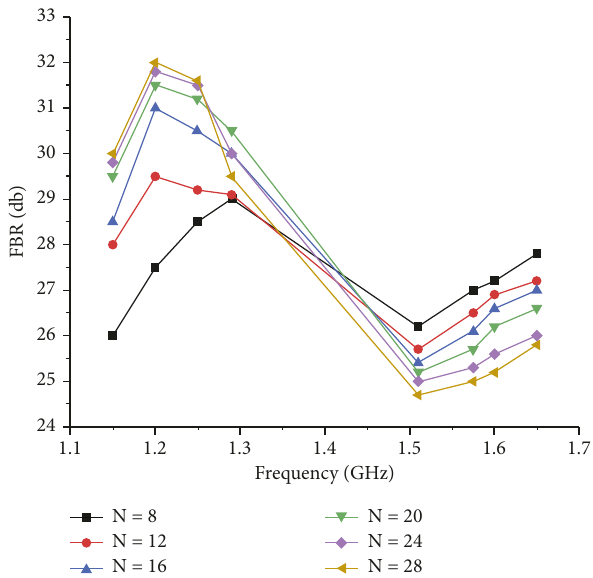
Figure 3: Influence of the trapezoidal number on the front-to-back ratio of the antenna.